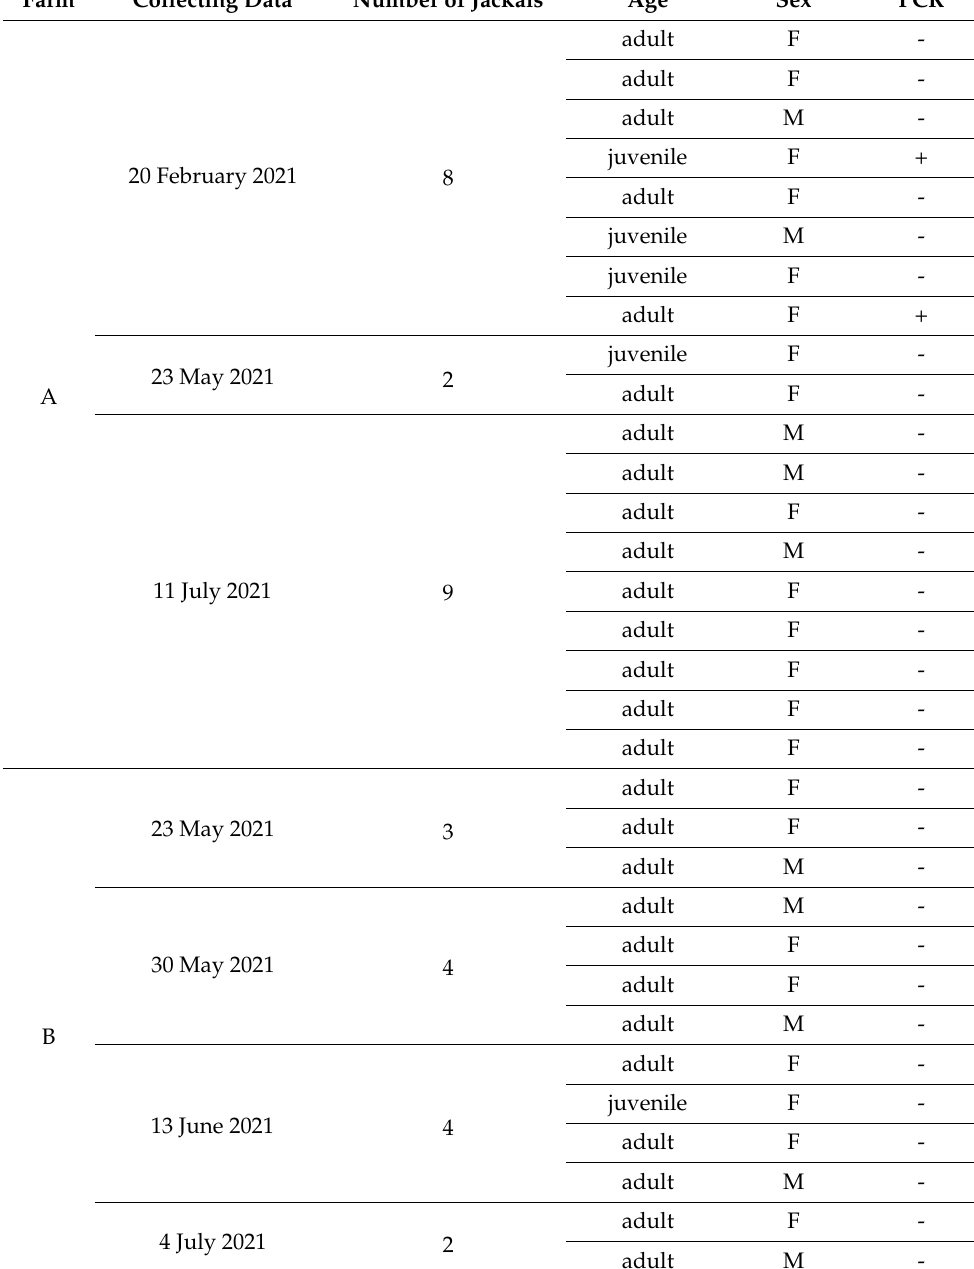
Table 1. Description of the analysed samples.